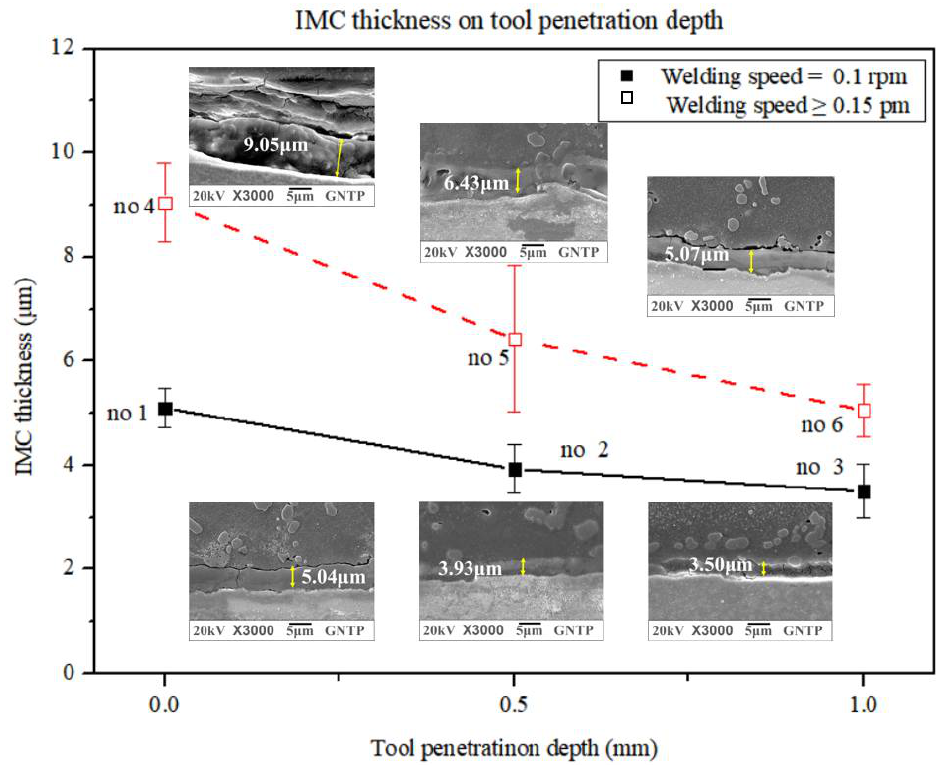
Figure 6. IMC thickness comparison according to TPD for experiment groups A and